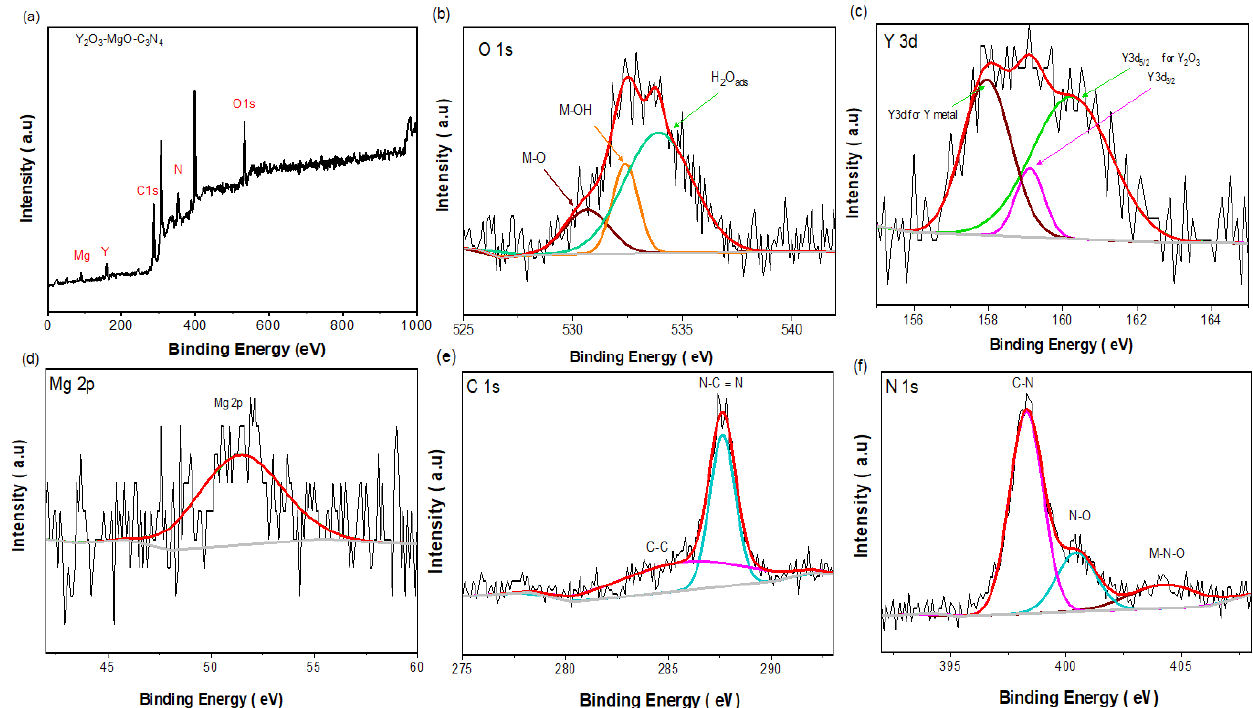
Figure 2. XPS spectra of ( a ) survey; ( b ) O 1s; ( c ) Y 3d; ( d ) Mg 2p; ( e ) C 1s; and ( f ) N 1s for Y2O3-MgO@g-C3N4 nanocomposite.